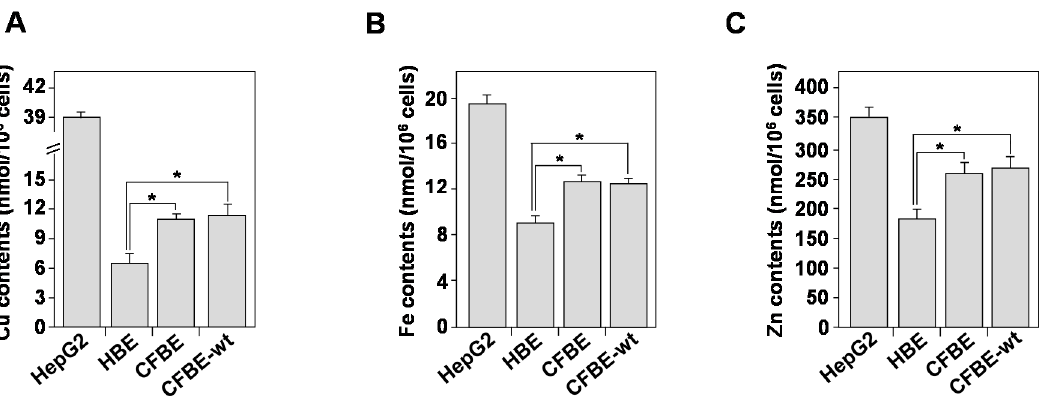
Figure 6. Inductively Coupled Plasma-Atomic Emission Spectrometry (ICP-AES) determination of biometals concentrations in healthy and CF bronchial cells. ( A ) Copper (Cu), ( B ) Iron (Fe), and ( C ) Zinc (Zn) content was assessed in HBE, CFBE, and CFBE-wt cells. For the control, the hepatocyte cell line (HepG2) was used as a positive control. Values overwritten with stars are significantly different from the control ( p < 0.05). Data are expressed as mean ± SE ( n = 6).